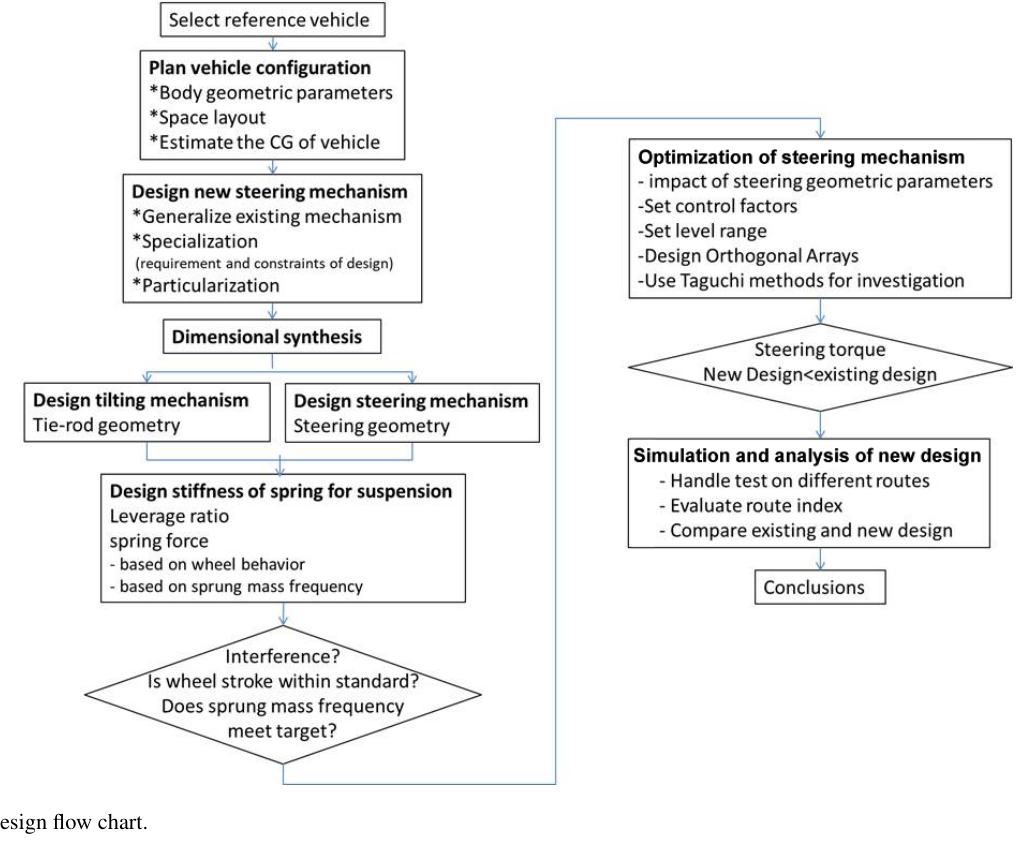
Figure 1. Design flow chart.